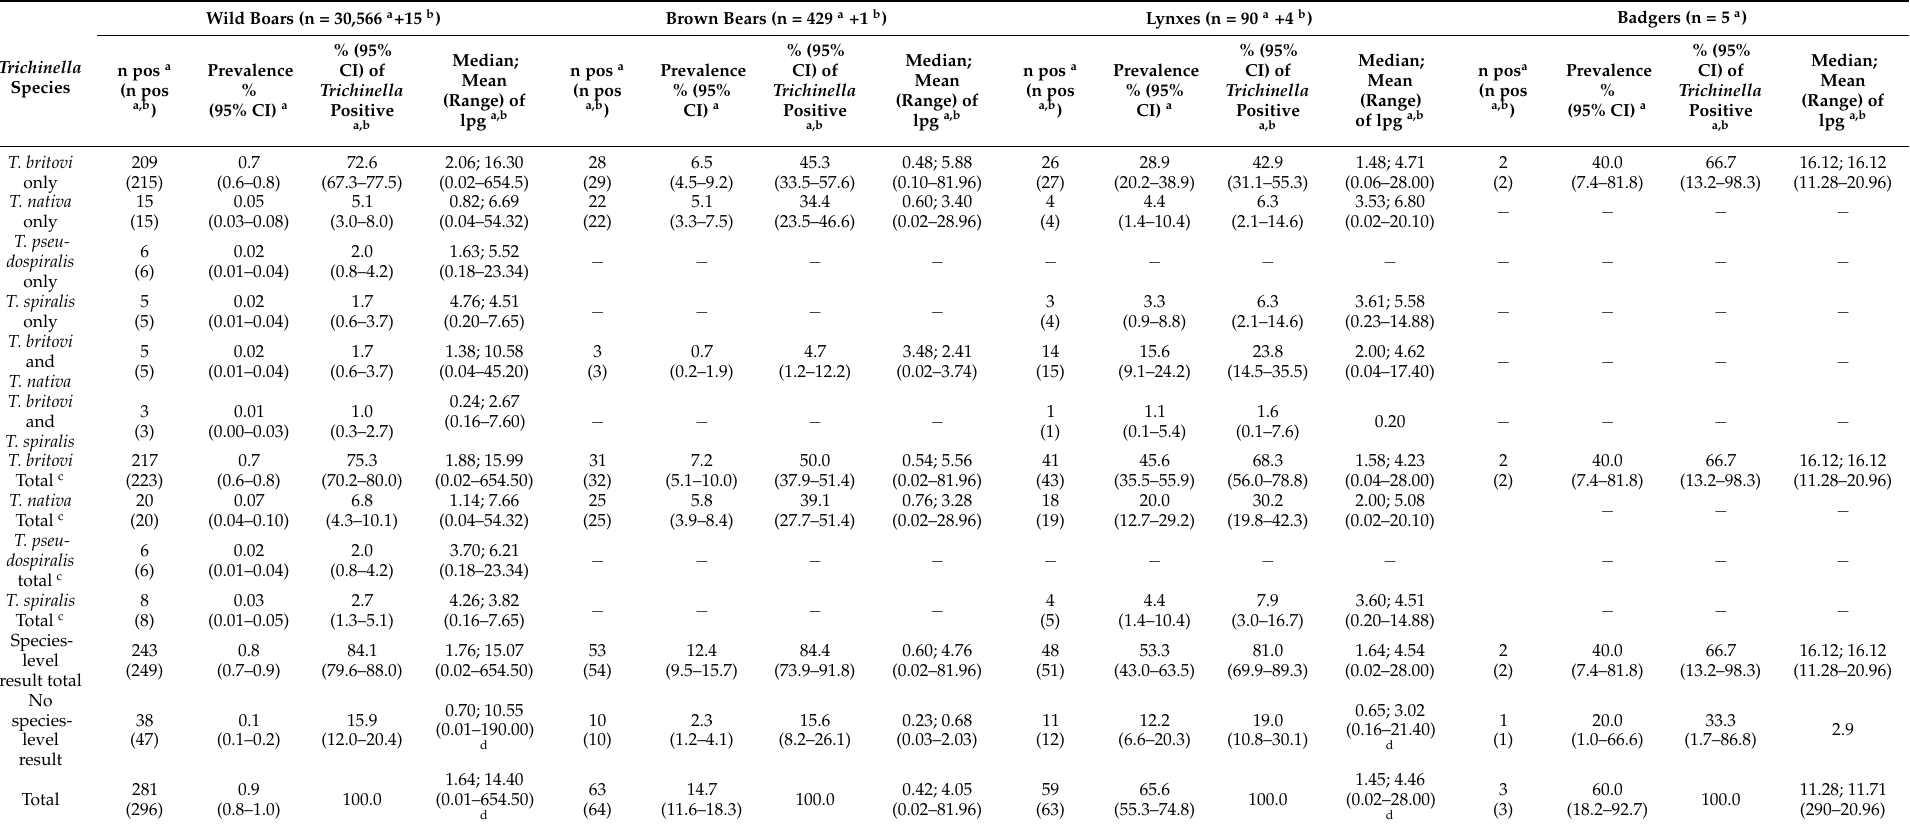
Table 2. Trichinella species identified in wild boars ( Sus scrofa ), brown bears ( Ursus arctos ), Eurasian lynxes ( Lynx lynx ) and badgers ( Meles meles ) hunted in 2007–2014 in Estonia.